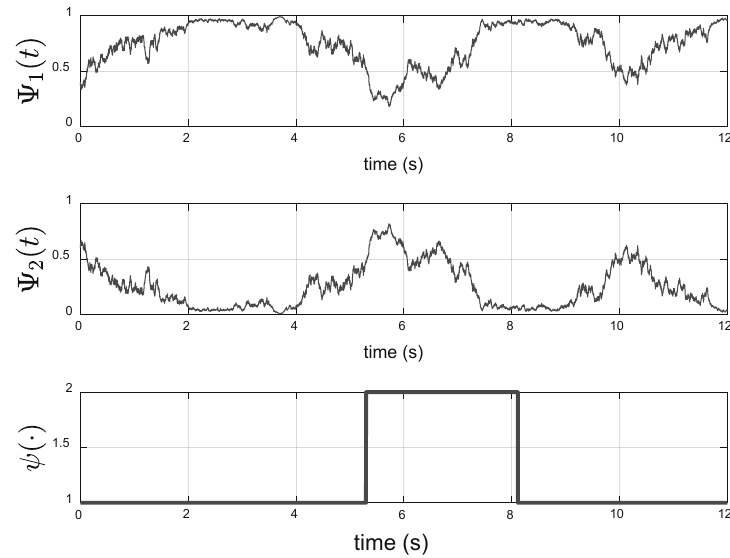
Figure 7. Wonham filter and hidden Markov chain (time interval [2,